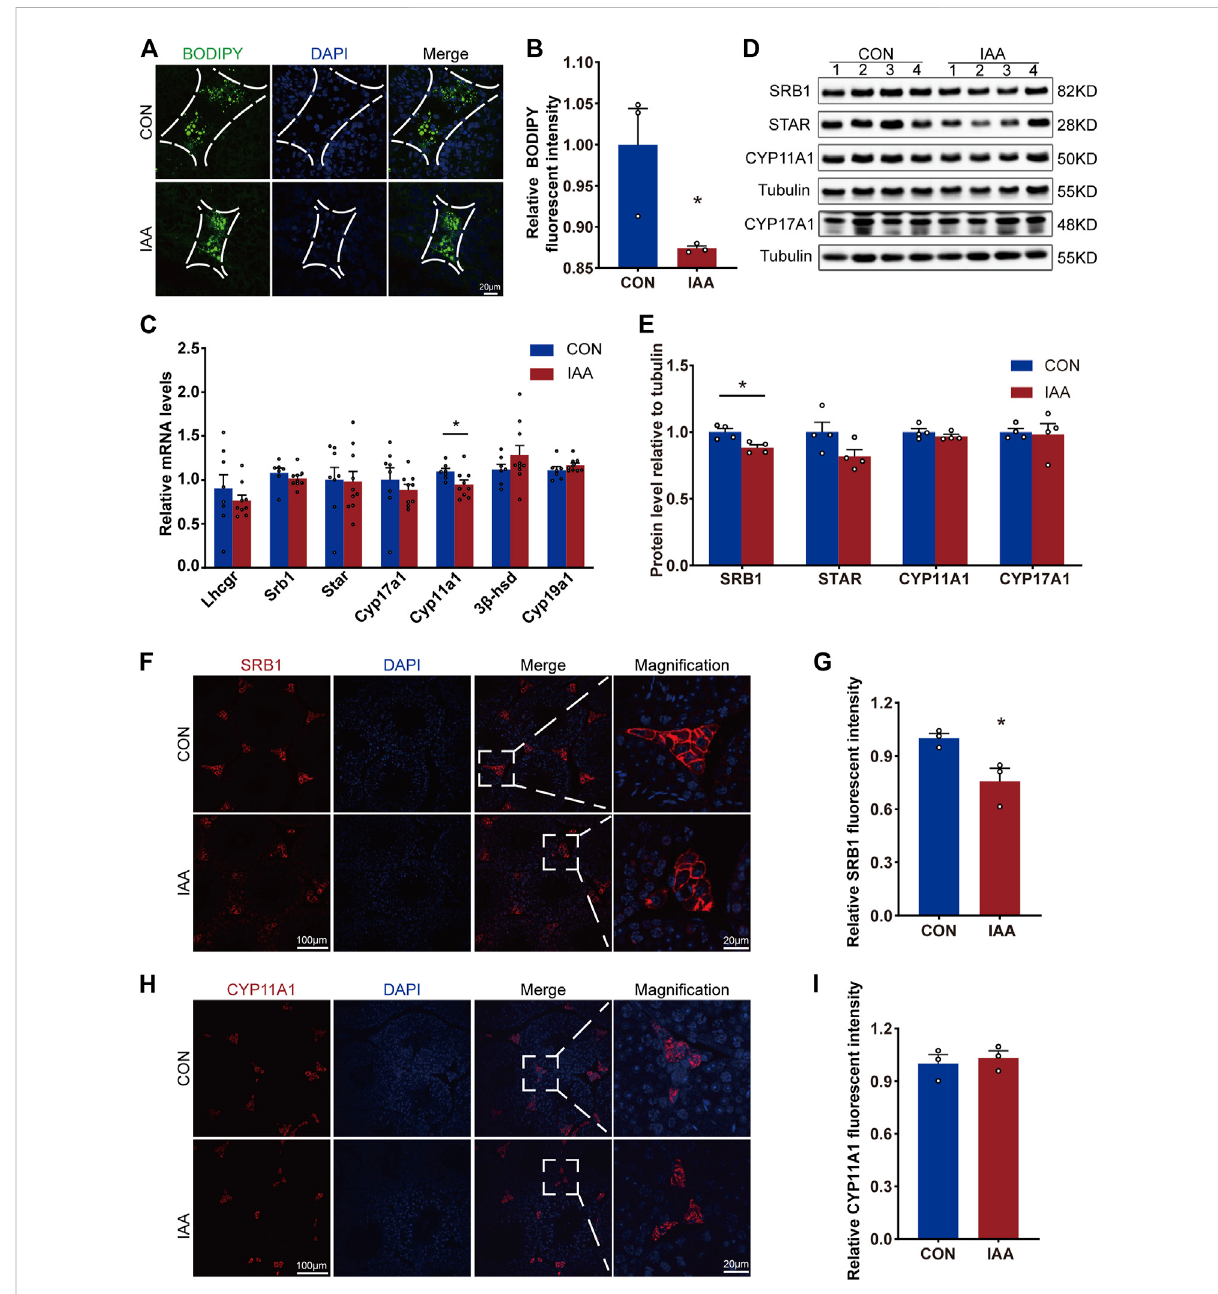
Lipid droplet storage inLeydig cellsand changes intestosteronesynthase from geneexpressionandproteinlevels wereexamined. Cholesterol storage in Leydig cells between the two groups was visualized by BODIPY staining (A,B) . The relative mRNA levels of the following indicators, Lhcgr, Srb1, Star, Cyp17a1, Cyp11a1, 3 β -hsd, and Cyp19a1, were detected by qRT-PCR (C) . Also, the protein levels of cholesterol transporter SRB1 and testosteronesynthaseSTAR, CYP11A1, andCYP17A1wereobserved byWesternBlot (D,E) and immuno fl uorescencestainingexperiments (F – I) . * Signi fi cant differences compared to the control ( p <